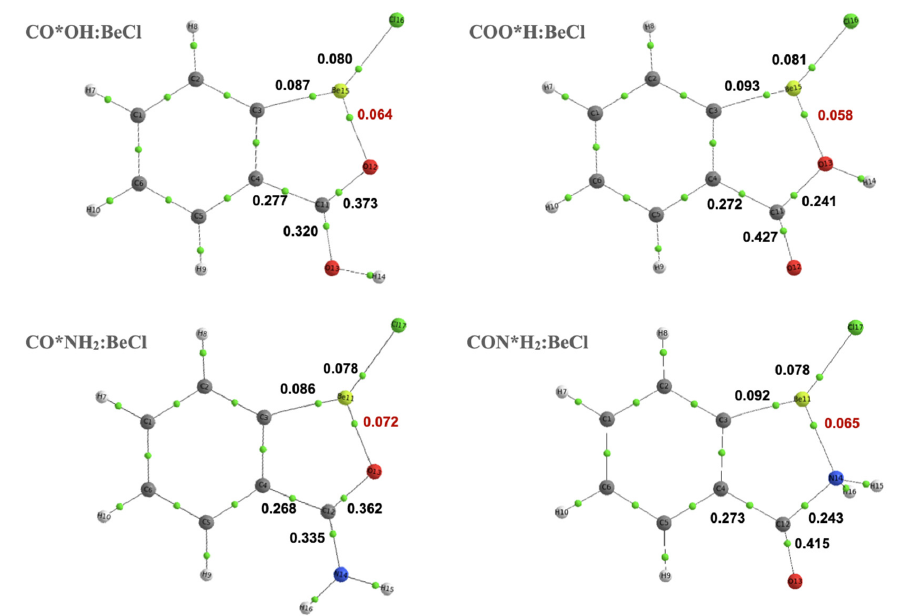
Figure 4. Molecular graphs for CO*OH:BeCl, COO*H:BeCl, CO*NH 2 :BeCl and CON*H 2 :BeCl derivatives showing the electron density (au) (red color) at the intramolecular beryllium bond.